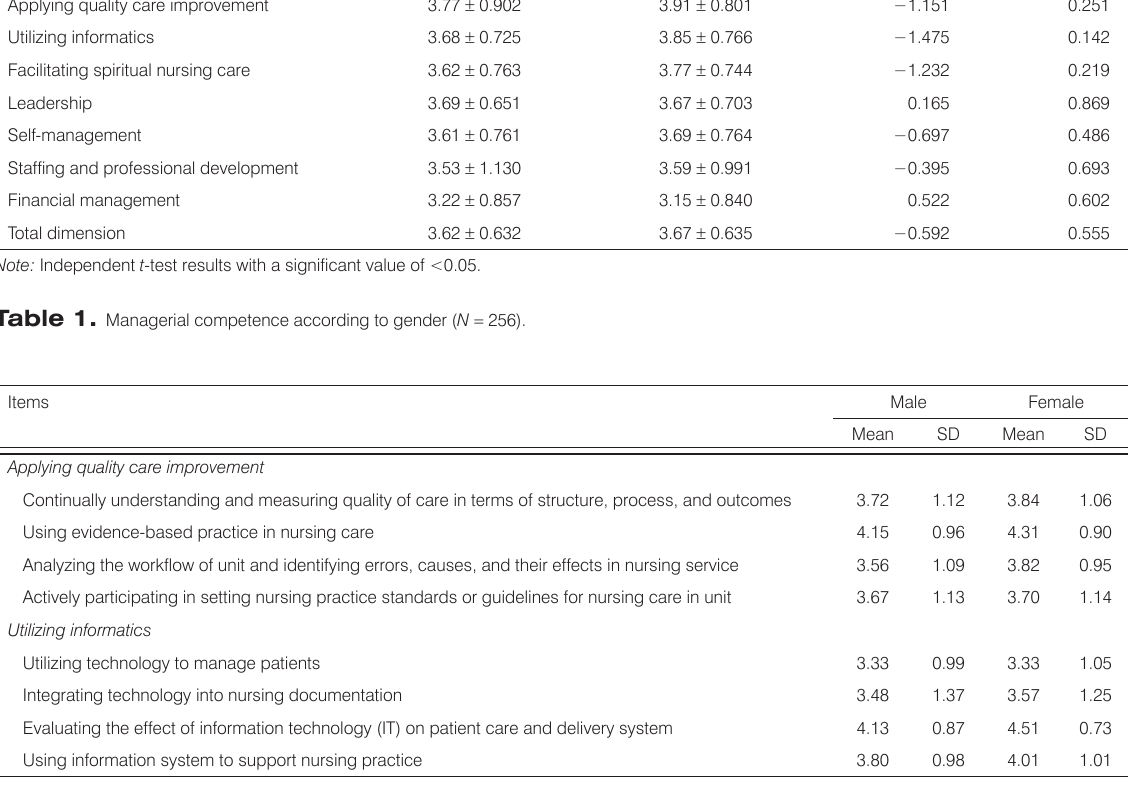
Table 2. Applying quality care improvement and informatics utilization dimension of managerial competence according to gender ( N = 256).